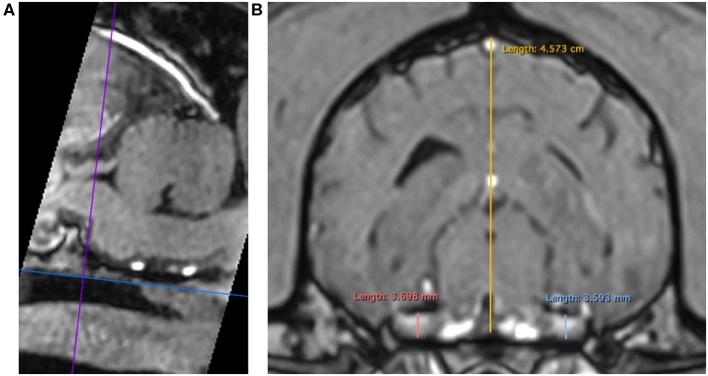
MPR of a 3DT1+C sequence of the brain of a Labrador Retriever (TR = 20.2 ms, TE = 10.3 ms, ST = 1 mm). Saggital reconstruction (A). The dorsal axis (blue line) is adjusted parallel to the basisphenoid bone to ensure the transverse axis (purple line) is perpendicular. Transverse reconstruction (B). Trigeminal nerves are identified coursing horizontally just caudal to the foramen ovale. Caliper measurements for HBR calculation: TTH left (light blue line), TTH right (coral pink line), and BH (yellow line). MPR, multiplanar reconstruction; 3DT1+C, three-dimensional T1-weighted post-contrast; TR, repetition time; TE, echo time; ST, slice thickness; TTH, trigeminal nerve transverse height; BH, brain height; HBR, height-to-brain ratio.